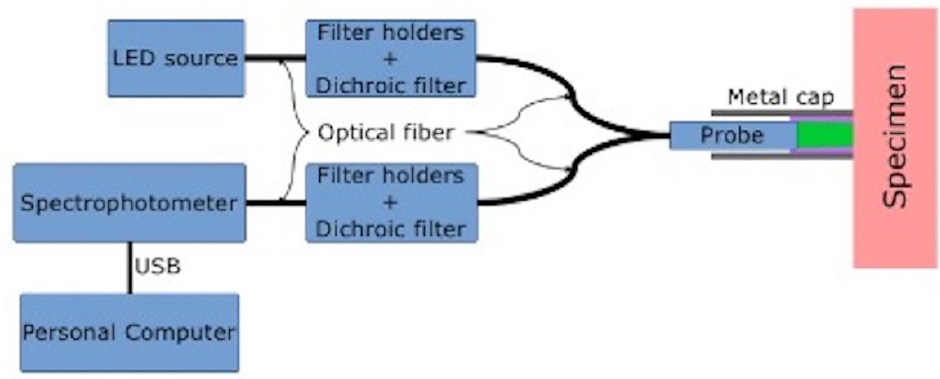
Figure 1. Basic representation of the AF detection system.